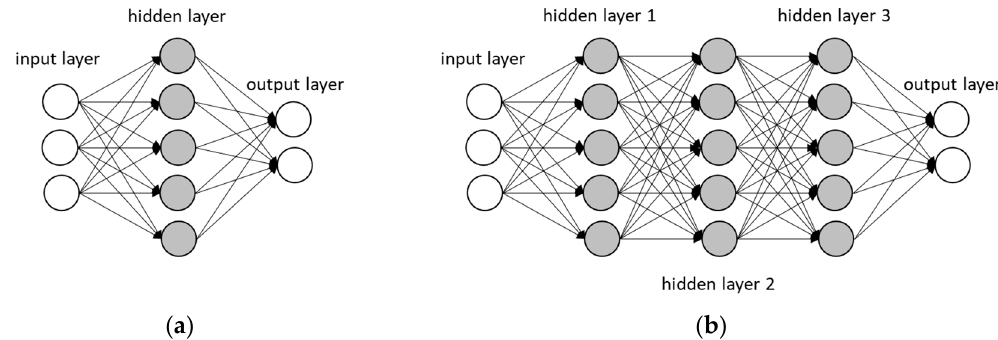
Figure 2. Network topology difference between ( a ) a traditional neural network and ( b ) a deep neural network.